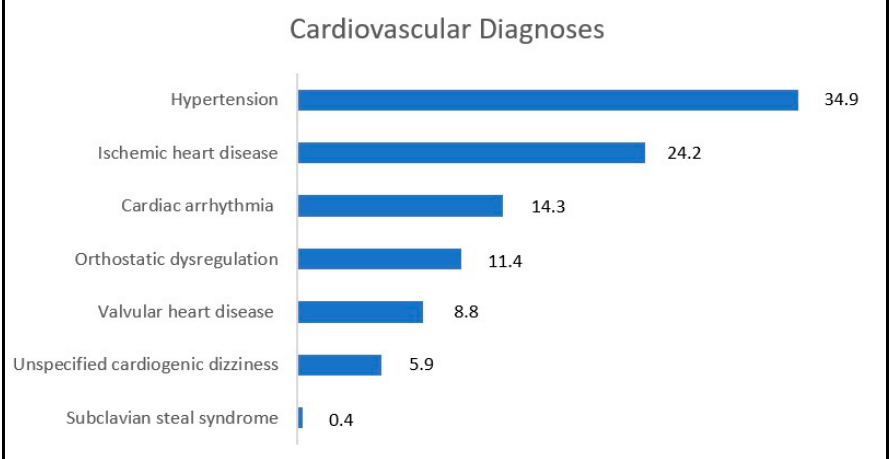
Figure 4. Cardiovascular diagnoses within the selected studies. All numbers are shown in percentages.